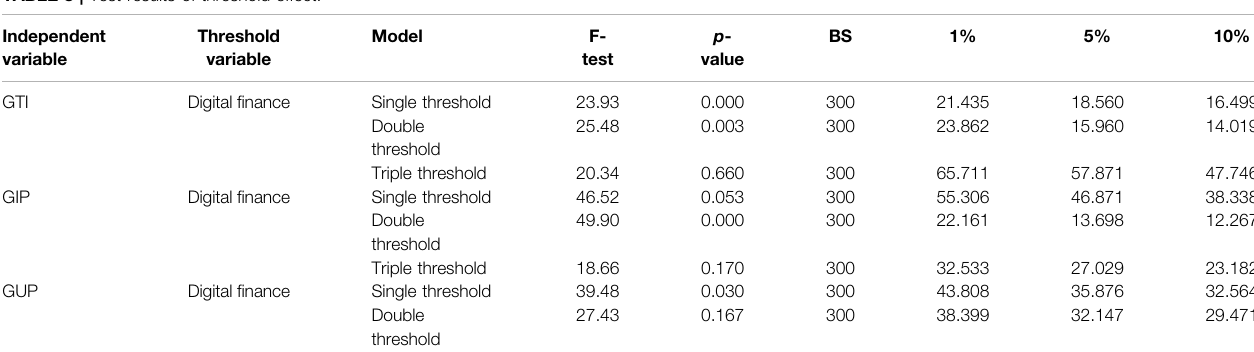
TABLE 8 | Test results of threshold effect. Independent